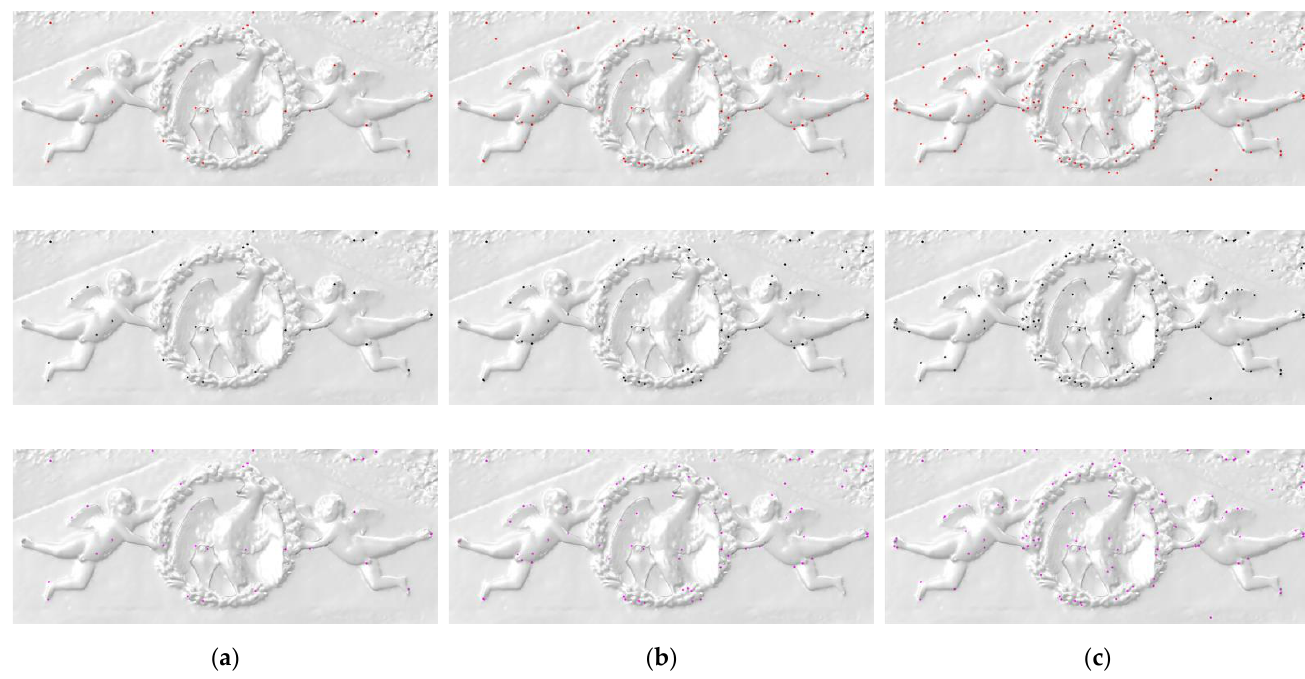
Within the mesh quantization step, we performed computations using various toler- ance factors and quantization levels. The illustrated comparison of the best obtained re- sults is presented in Figure A3.